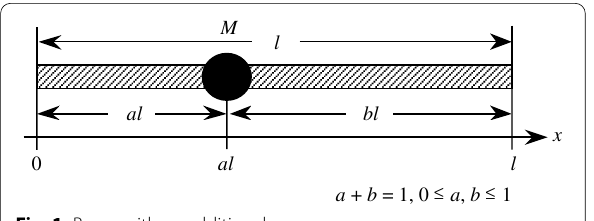
Fig. 1 Beam with an additional mass